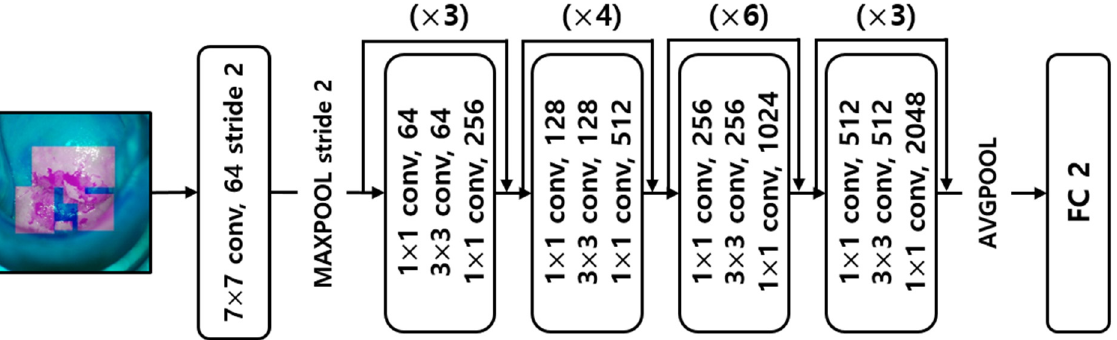
Figure 3. Diagram of the ResNet 50 model architecture.